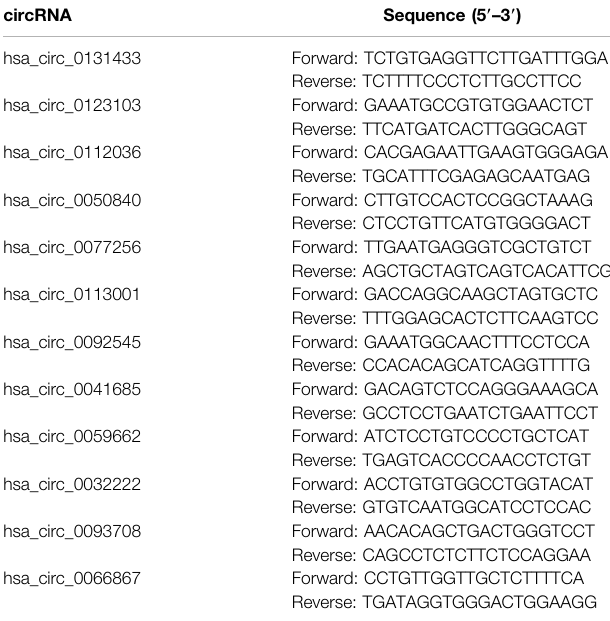
TABLE 2 | The primer sequences of 12 differentially quanti fi ed